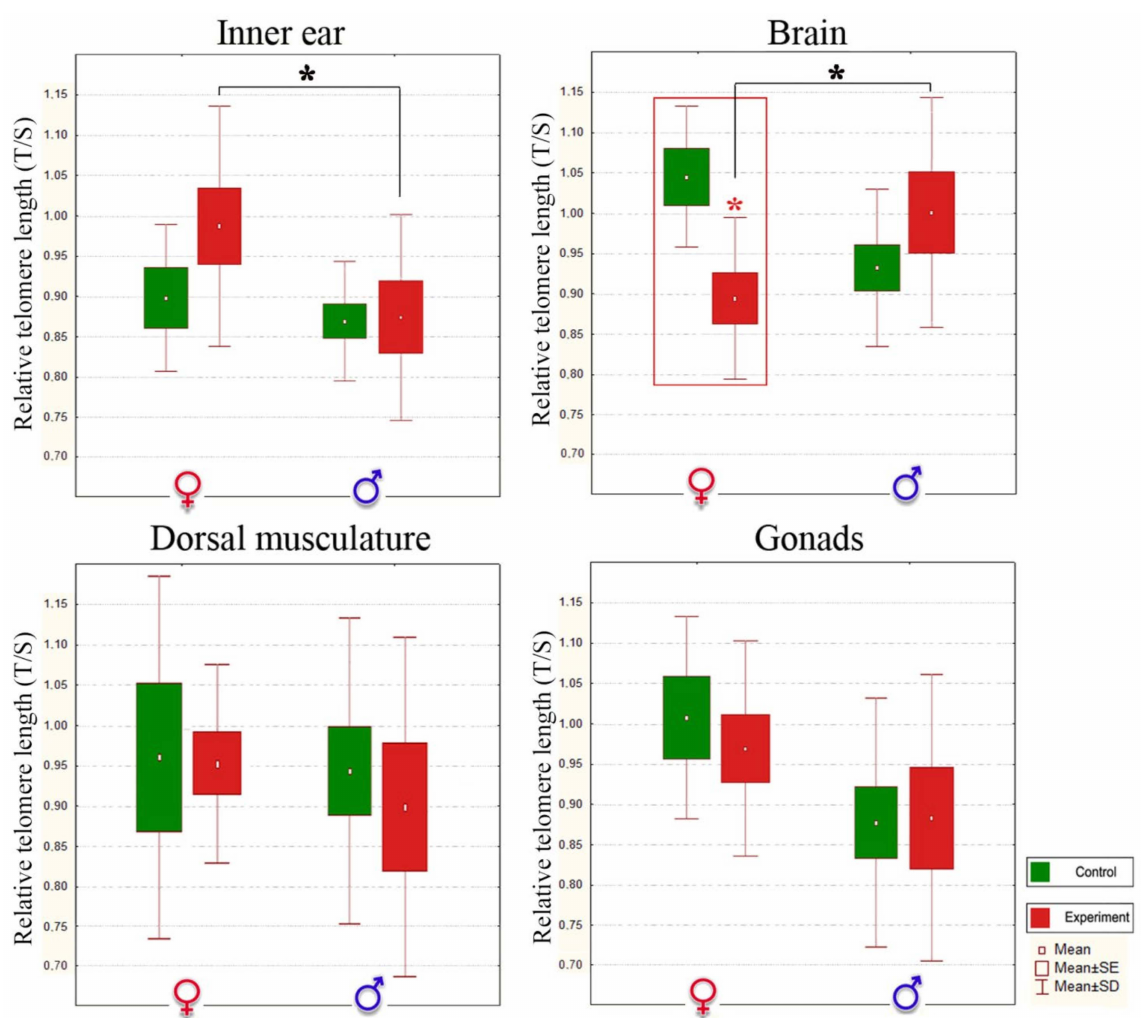
Figure 4. Relative telomere length (T/S) in control and noise-exposed stone sculpin males and females. T—concentration of telomere DNA, S—DNA concentration of reference gene, SD—standard deviation, SE—standard error. A statistically significant decrease in telomere length was observed in the brain of females between control and experimental samples and marked with a red asterisk. Statistically significant differences between the sexes in the experimental group are shown with a black asterisk: * p < 0.05, Kruskal-Wallis test.